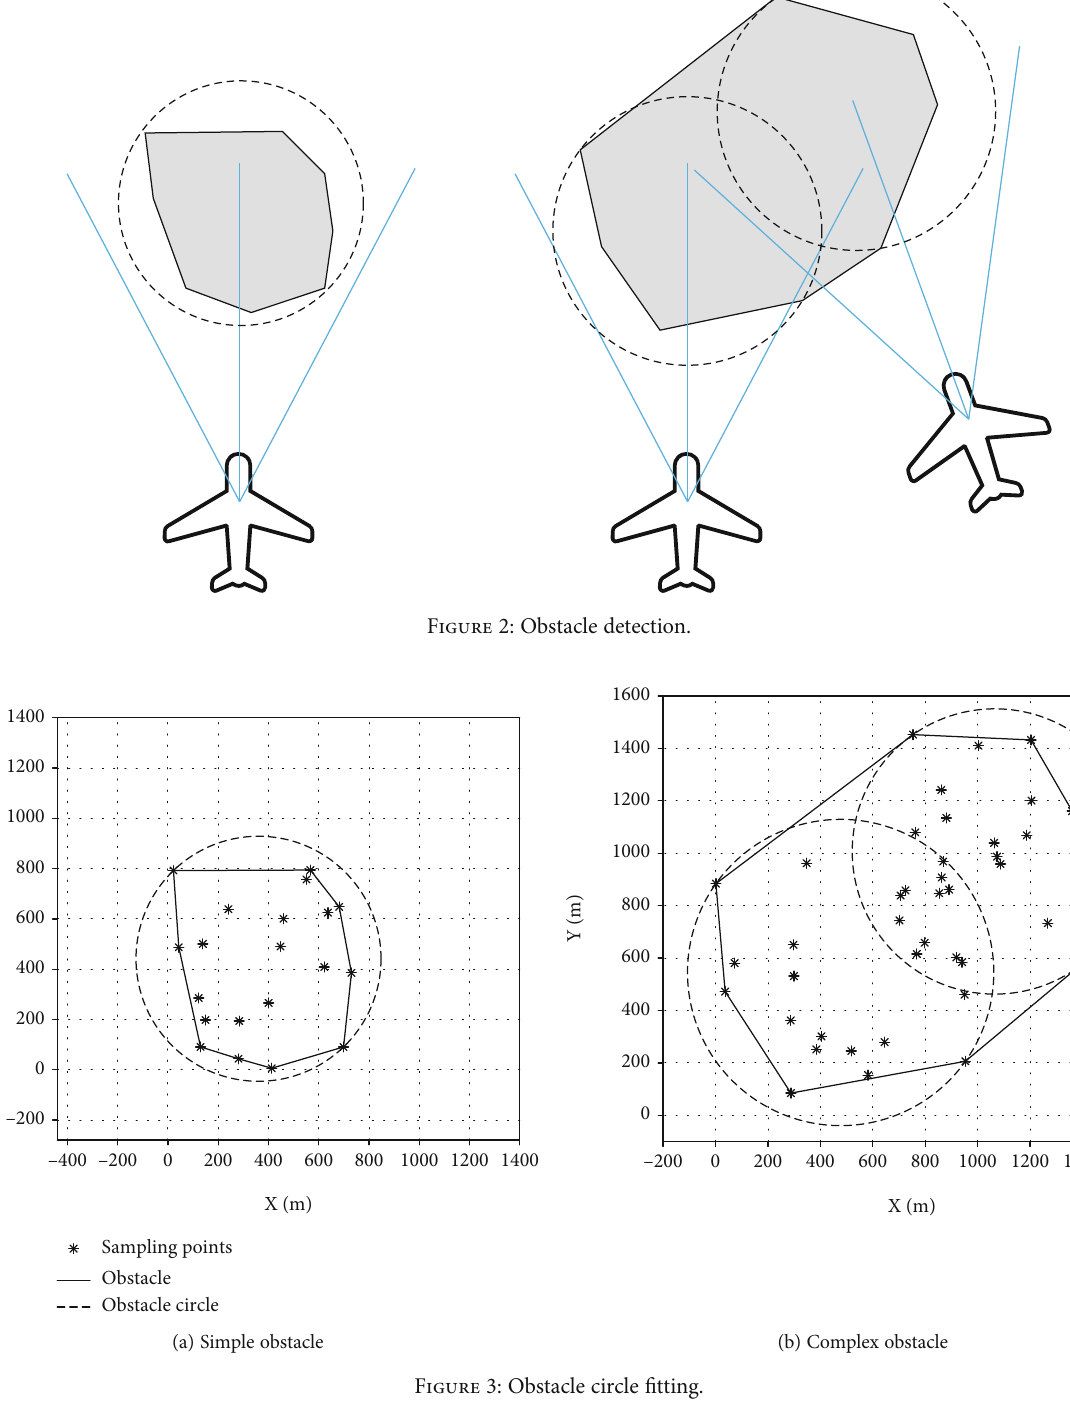
Figure 3: Obstacle circle fi tting.